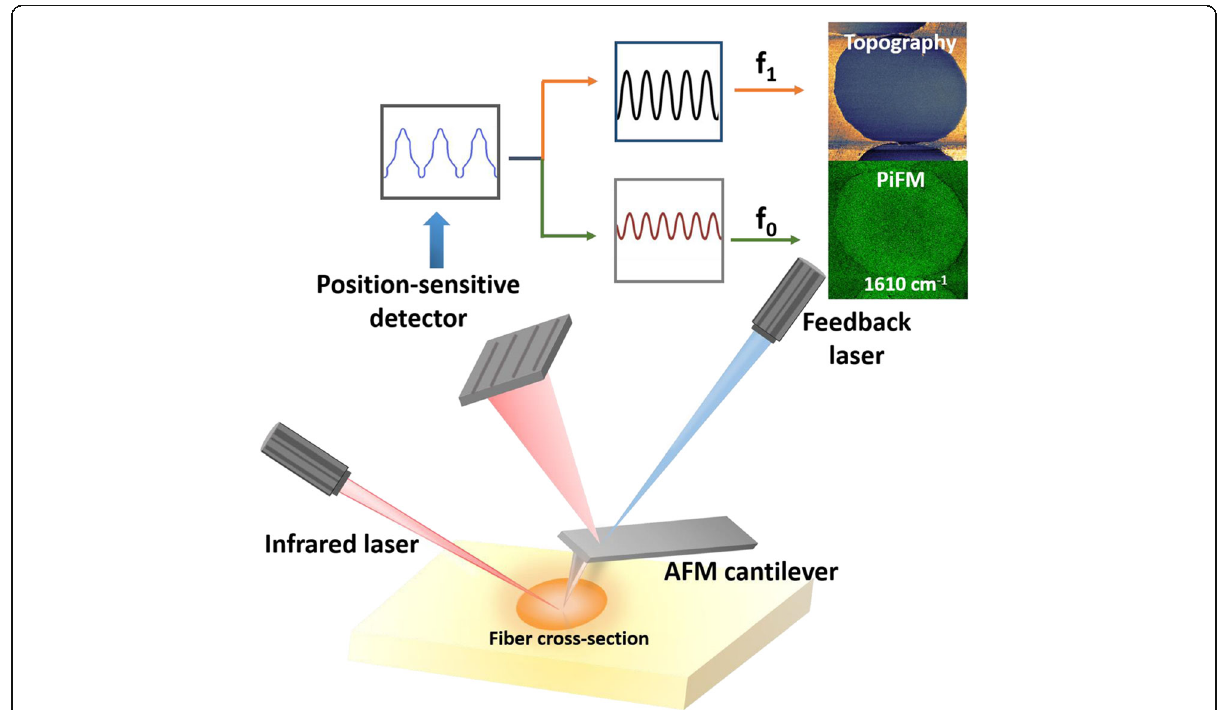
Fig. 1 Simplified schematic of the photo-induced force microscopy (PiFM)